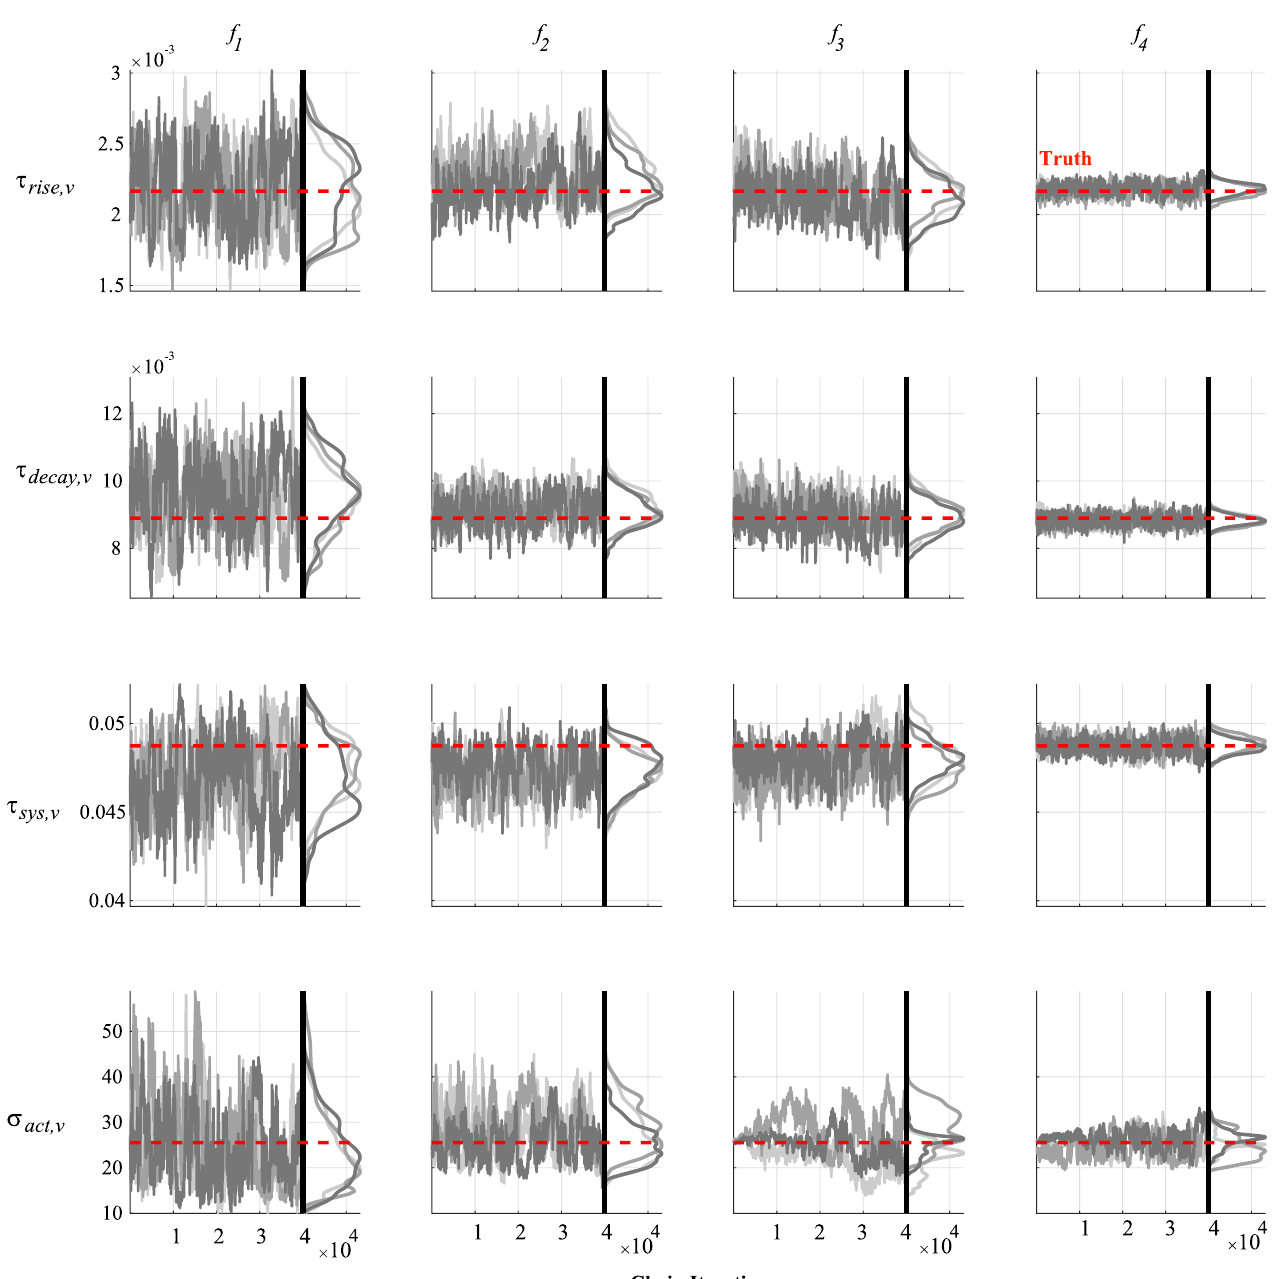
Fig 7. Chain iterations and marginal posteriors after MCMC for the sarcomere parameters. Similar to Fig 6, three of the twelve MCMC instances are provided for the sarcomere parameters important for the rise, decay, and length of fiber shortening ( τ force generation ( σ act , v ). Note that all four experimental designs (given by each column) provide sufficient information to the likelihood so that the true data generating parameters (in red) are within the marginal